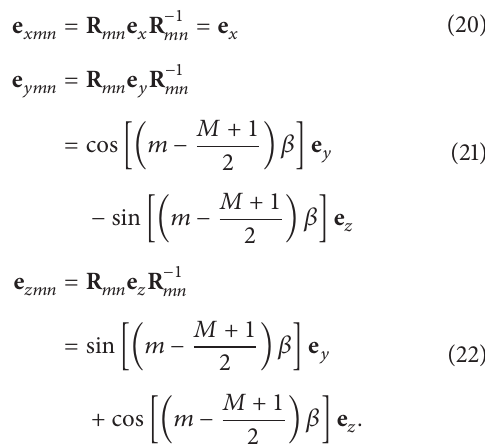
Figure 5: The local coordinate of (𝑚,𝑛) th